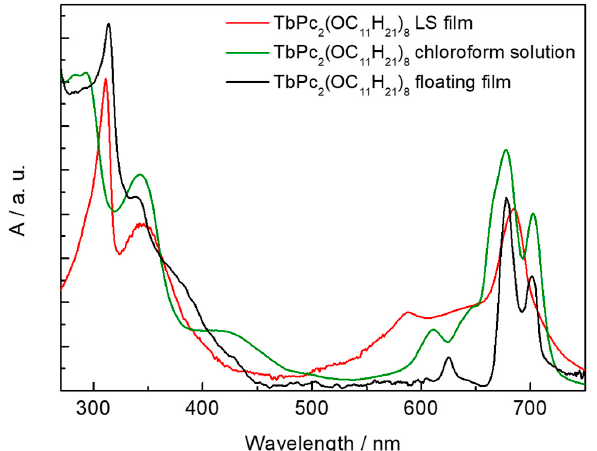
Figure 6. UV-VIS electronic absorption spectra of the TbPc 2 (OC 11 H 21 ) 8 macrocycle as floating film, in chloroform solution and in L-S thin film form deposited onto silica glass substrate.